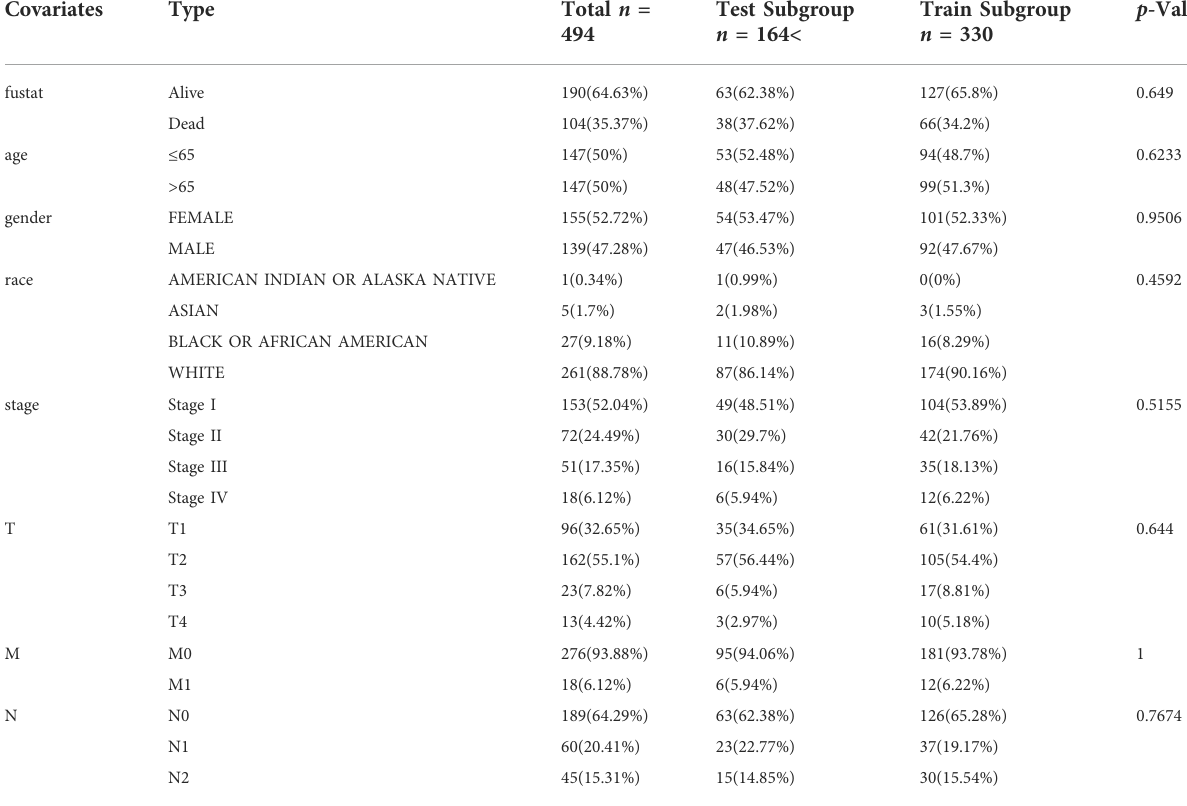
TABLE 1 Clinical data of training subgroup, validation subgroup and whole